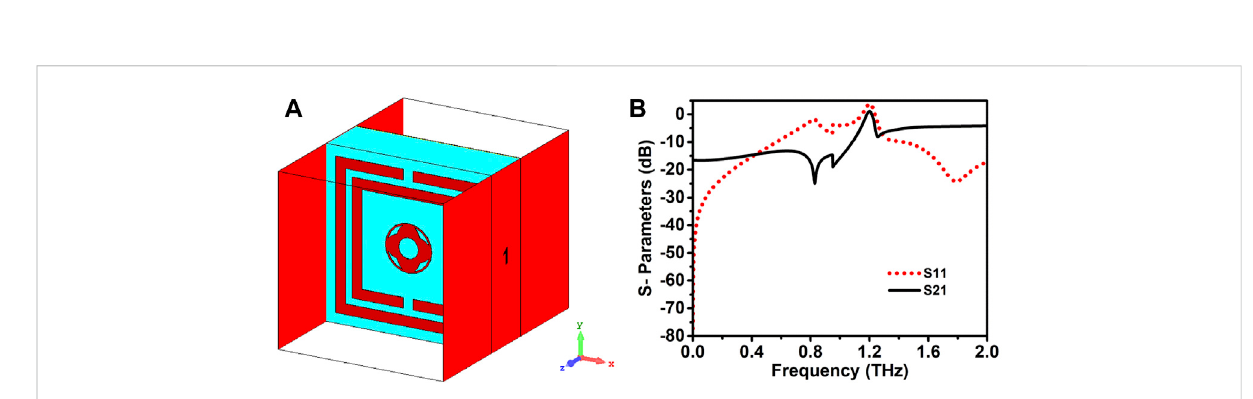
FIGURE 13 (A) The simulated setup showing wave propagation in the x -axis and (B)